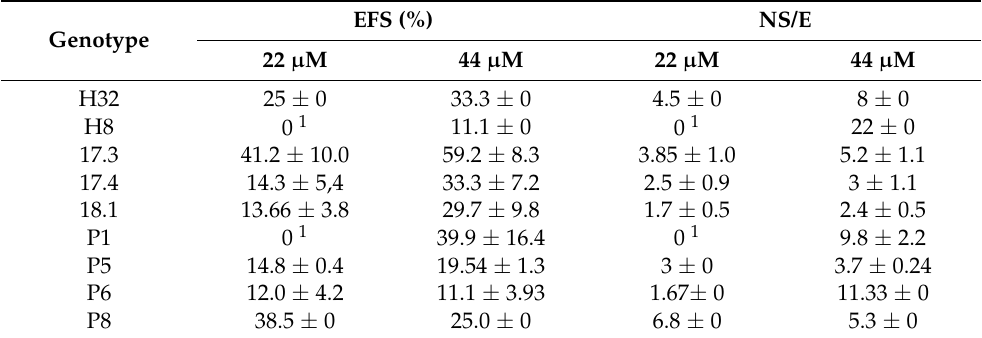
Table 4. Values for EFS (%) (explants forming shoots) and NS/E (number of shoots formed per explant) for Pinus halepensis apical shoot buds from different genotypes, induced under two different concentrations of BA (22 and 44 µ M).